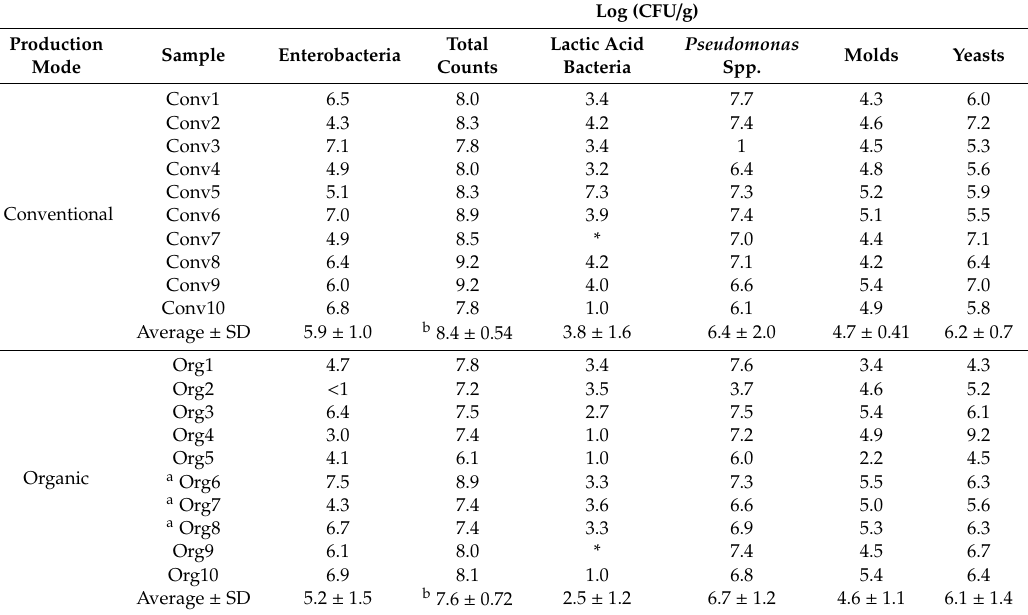
Table 2. Microbiological characteristics of organic and conventional lettuce